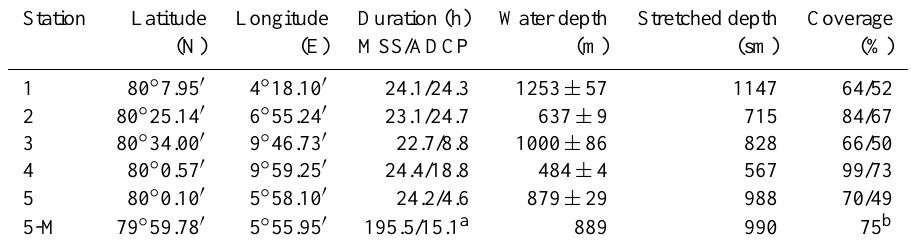
Table 1. Summary of station position, sampling duration, and vertical coverage; 5-M is the mooring located near station 5. Water depth is the mean ± 1SD over the station duration. The corresponding stretched depth (in stretched metre; sm) and the covered fraction are listed for a range of 3–500m for MSS and 12–360m for the